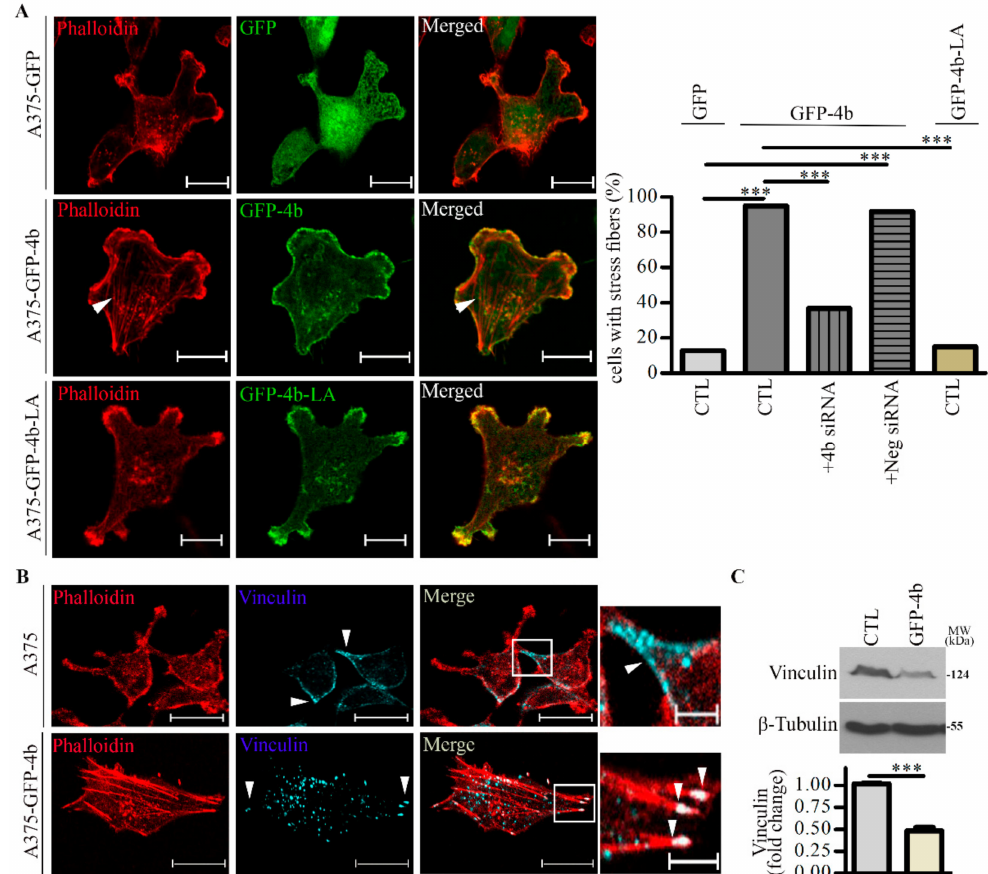
Figure 3. Lamellipodia and stress fiber formation are increased in A375 cells expressing GFP-PMCA4b but not in those expressing GFP-PMCA4b-LA. ( A ) Confocal microscopy images of A375-GFP, A375-GFP-PMCA4b, and A375-GFP-PMCA4b- LA cells labeled with Phalloidin-TRITC. Arrowheads show stress fibers. Scale bar, 20 µ m. The fractions of stress fiber-positive cells in A375-GFP ( n = 55), A375-GFP-PMCA4b-LA ( n = 72), A375-GFP-PMCA4b ( n = 60) ± PMCA4b siRNA ( n = 68), and negative siRNA ( n = 49) cultures were determined. siRNA confocal microscopy images are presented in Figure S3A. Relative abundance of cells with stress fibers is indicated by the bar graph. Confocal sections were taken from the bottom of the cells to show the stress fibers. ( B ) Confocal microscopy images of A375 and A375-GFP-PMCA4b cells immunostained with vinculin and labeled with Phalloidin-TRITC. Scale bar, 20 µ m. Insets show part of the cells with higher magnification. Arrowheads show the differential localization of vinculin. Scale bar, 5 µ m. ( C ) A375 and A375-GFP-PMCA4b cells were cultured in a 6-well plate for 48 h. Vinculin protein expression from total cell lysate was analyzed by Western blotting. β -tubulin was used as a loading control. Data represent mean ± S.E.M from three independent experiments (*** p <